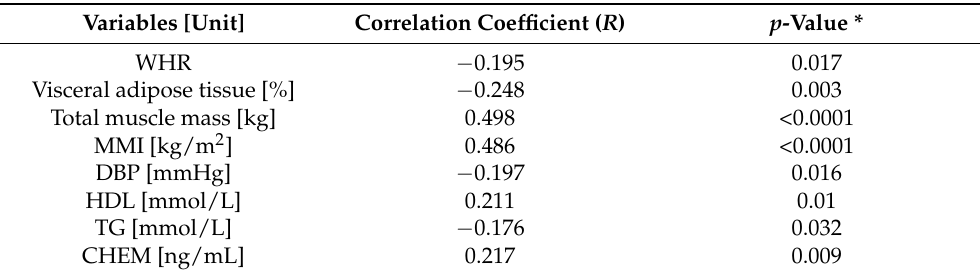
Table 2. Indices of correlation and levels of statistical significance for the relationship between NPQ and selected anthropometric and biochemical parameters in the entire population ( n = 149).